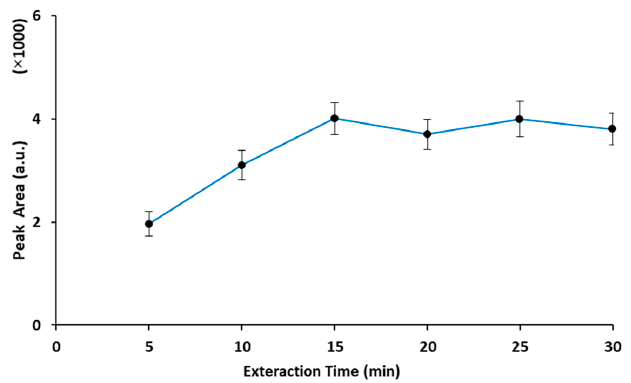
Figure 3. Effect of extraction time on the extraction efficiency of the HS-SPME–GC method for analysis of MTBE in solid samples. (Analyte concentration: 2 µg·g − 1 , extraction temperature: 30 °C, desorption condition: 2 min at 250 °C.)